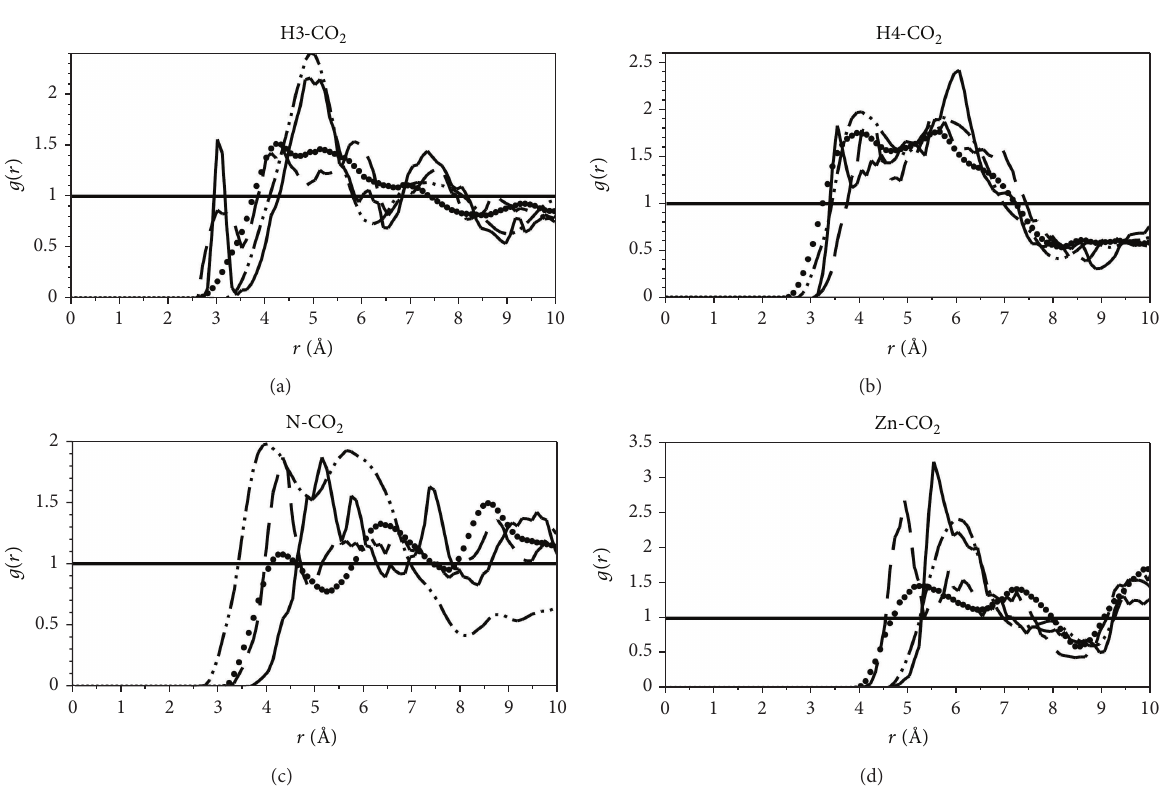
Figure 6: The obtained (a) H3-CO 2 , (b) H4-CO 2 , (c) N-CO 2 , and (d) Zn-CO 2 RDFs of SIM I (—X–C, – ∙∙ –X–O) and SIM II (––X–C, ∙ ∙ ∙∙ X–O) when X=H3, H4, N, and Zn,